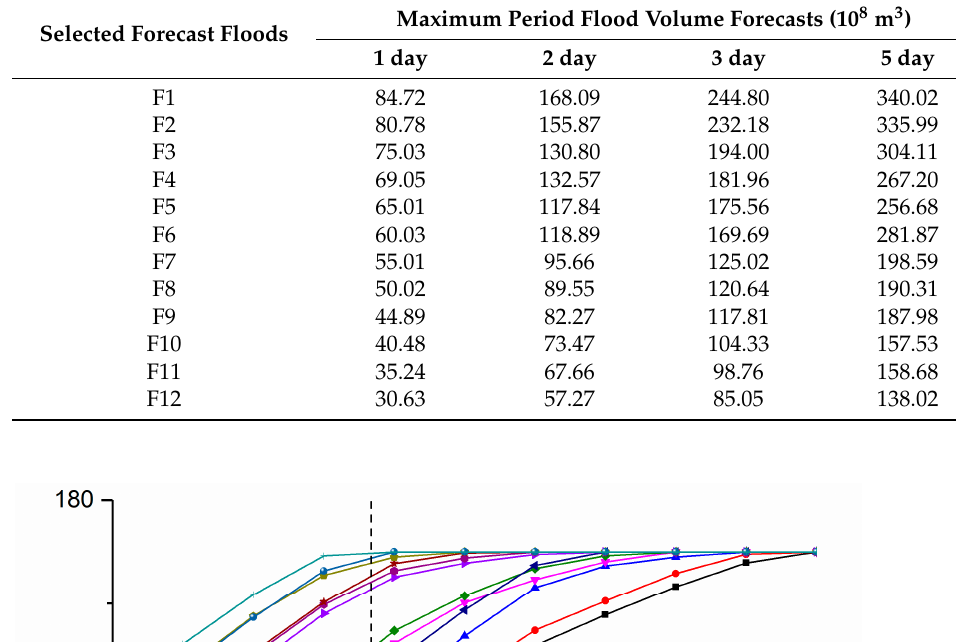
Table 3. Twelve selected representative forecast flood groups.